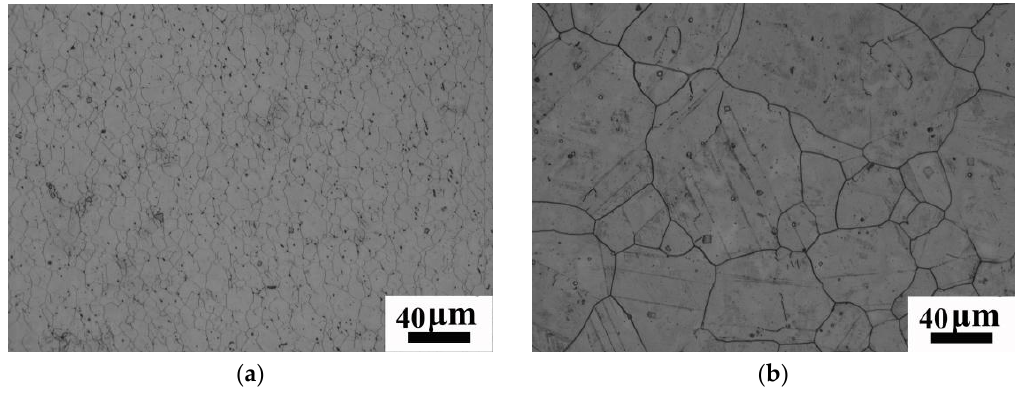
Figure 2. Microstructure of the austenitic steel: as-received condition ( a ); after quenching ( b ).